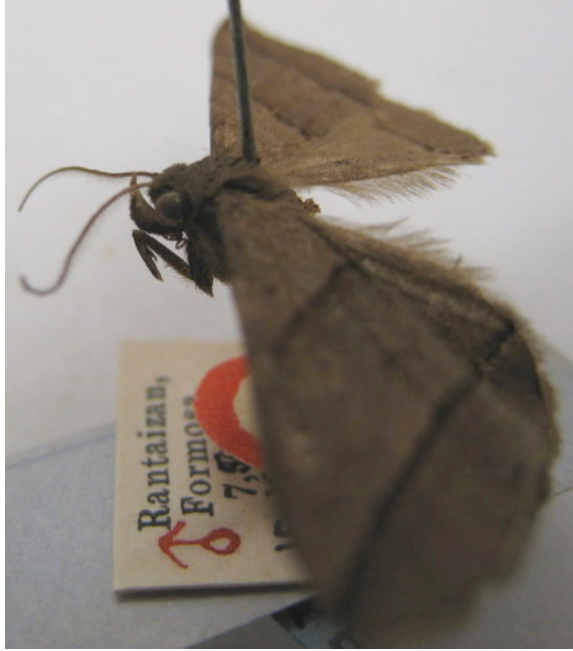
Image 5. Orthozona curvilineata male syntype showing palpi (BMNH).